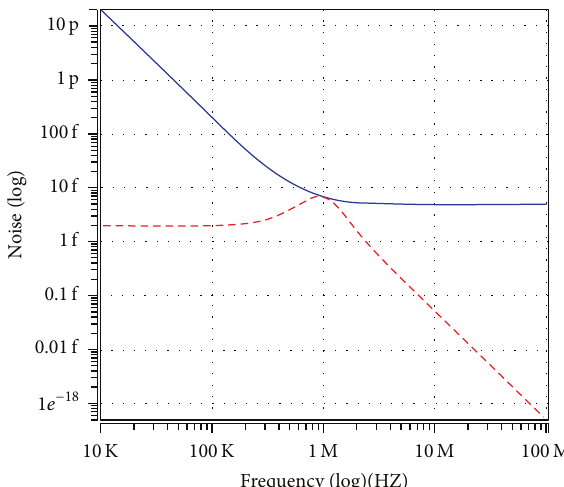
Figure 15: Equivalent input (blue line) and output (red line) noise of BP filter versus